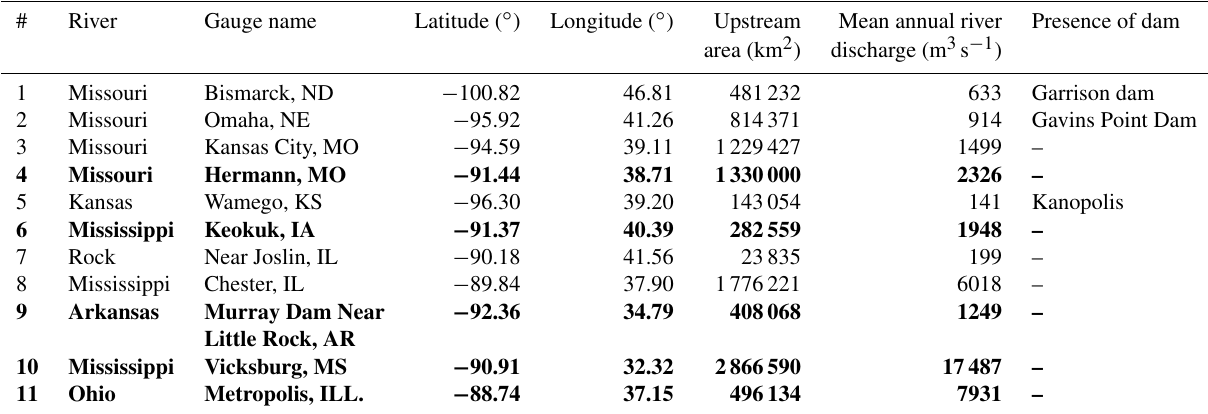
Table 1. Location of river discharge gauging stations over the Mississippi basins and contributing upstream area. Bold text is used to indicate gauges where the STREAM model has been